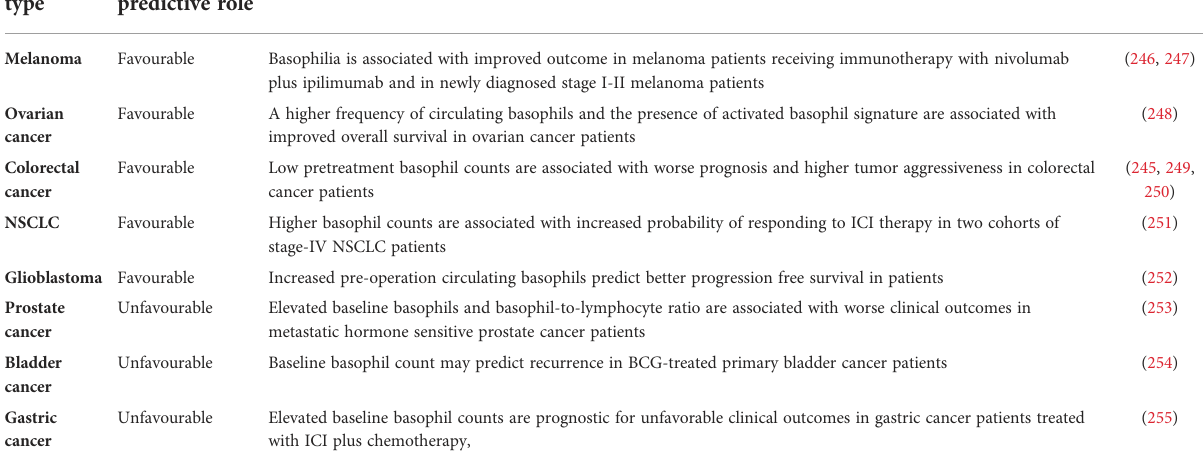
TABLE 1 Role of peripheral blood basophils in human solid